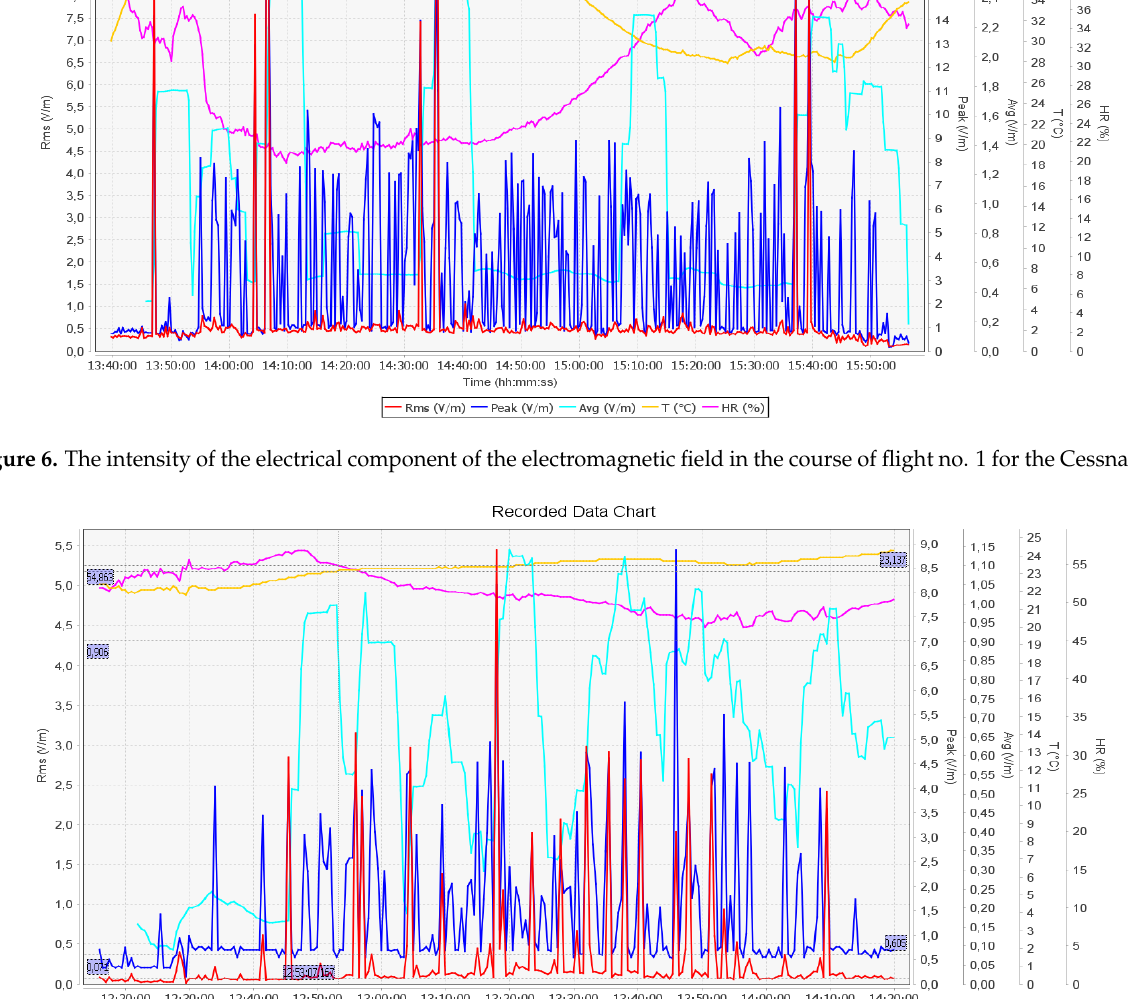
Figure 7. The electric field in the course of flight no. 2 for the Cessna 172.